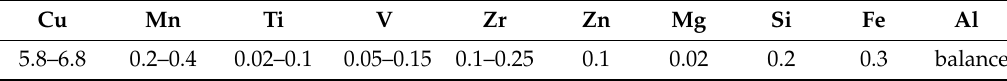
Table 1. Composition of EN AW-2219 according to [7] in wt %; single numbers mean upper limits.